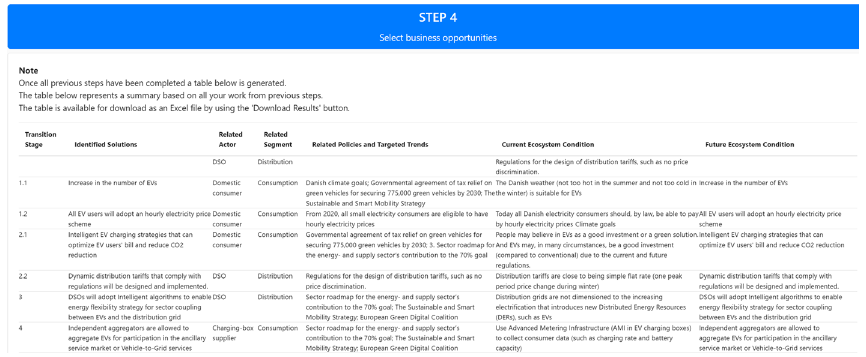
Fig. 6 Screenshot for the final evaluation